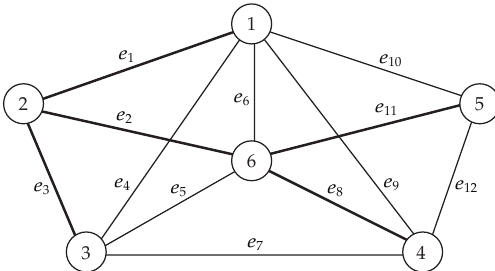
Figure 4: Optimal spanning tree of our proposed BST problem with the